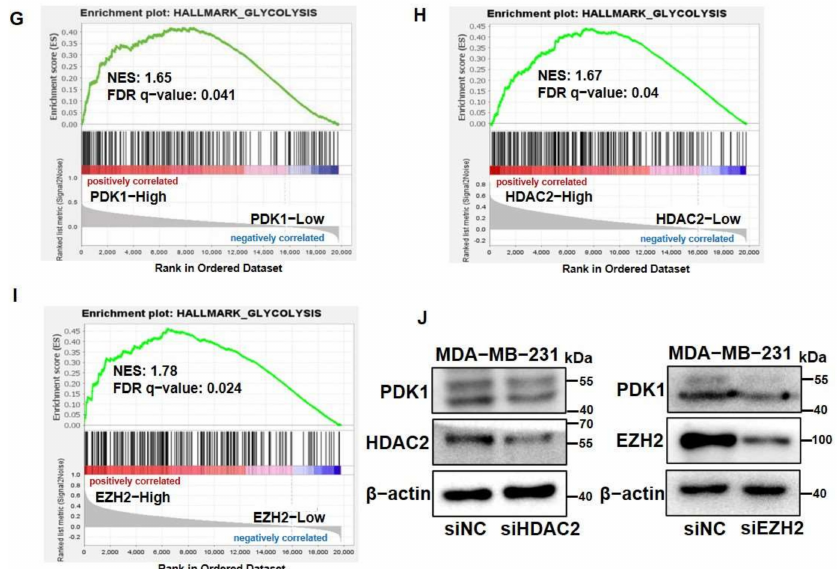
Figure 1. PDK1 levels were upregulated by HDAC2 and EZH2, which are associated with glycolysis. ( A ) The expression levels of PDK1 were analyzed in normal and breast cancer tissues from GEO dataset (GSE22820). ( B ) The relapse-free survival time was analyzed in groups with high and low expression of PDK1. ( C ) The protein levels of PDK1 were detected by Western blotting in MCF10A, MCF7, and MDA-MB-231 breast cancer cell lines. ( D ) The Pearson’s correlation analysis was conducted to test the correlation between levels of PDK1 and HDACs, including HDAC1-7. The data distribution, correlation coefficients between genes, and statistical significance were shown; the most significant correlation is indicated with a red border. ( E ) The Pearson’s correlation analysis was used to verify the correlation between PDK1 and PRC2, including EZH2, SUZ12, and EED levels. ( F ) HDAC2 and EZH2 protein levels were detected by Western blotting ( G – I ). The GSEA